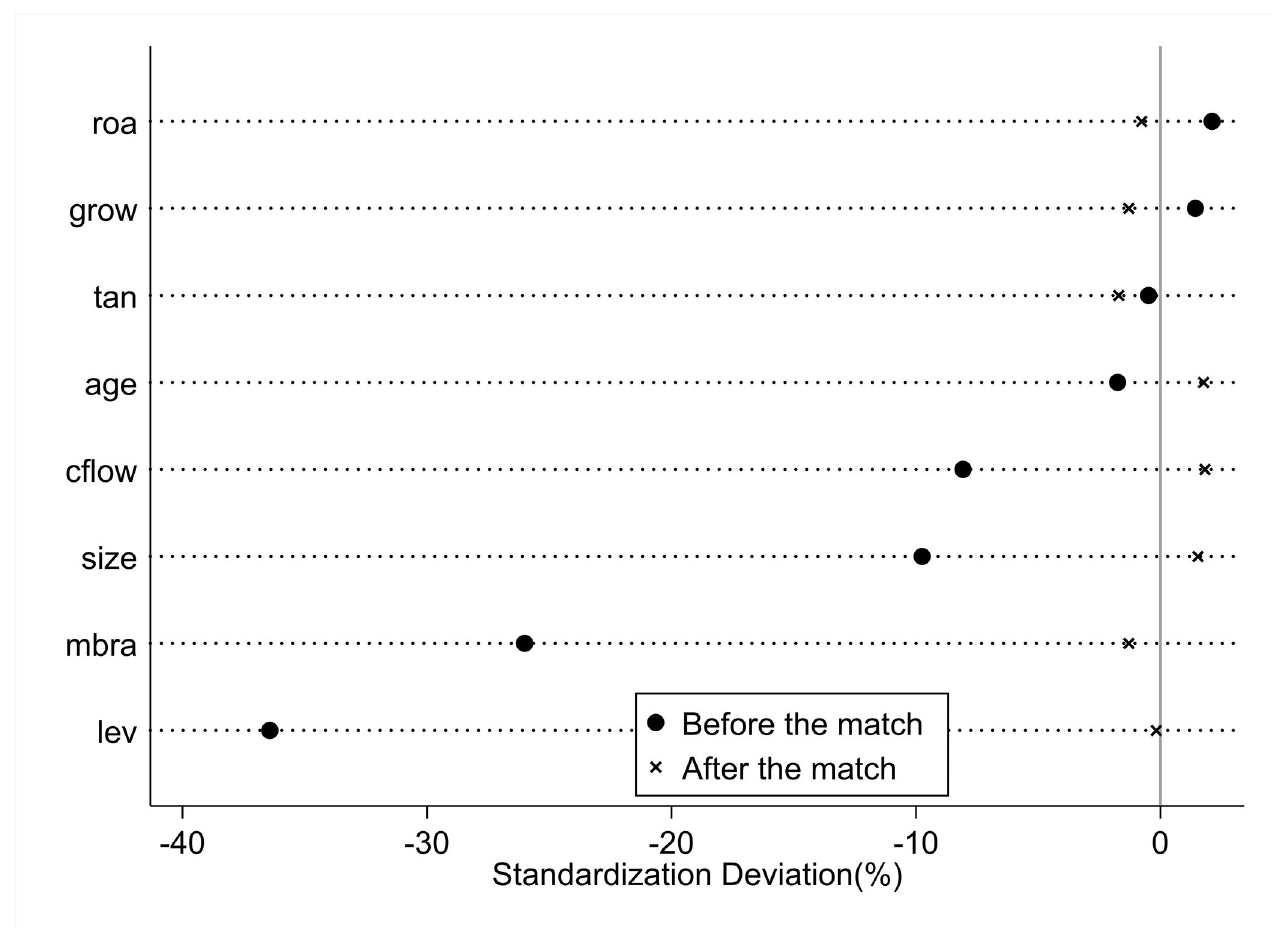
Fig 3. Standardized deviation of covariates before and after